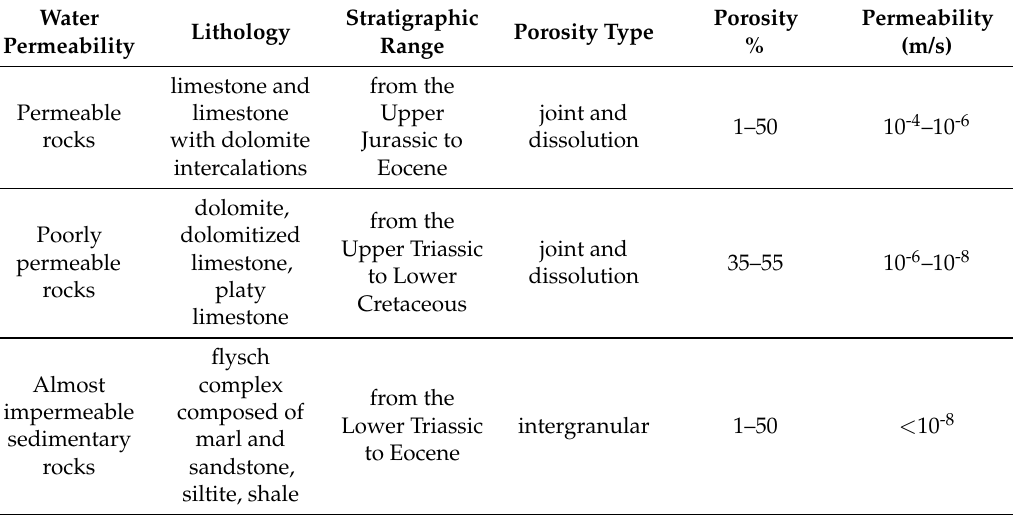
Table 1. Hydrogeological classification of rock